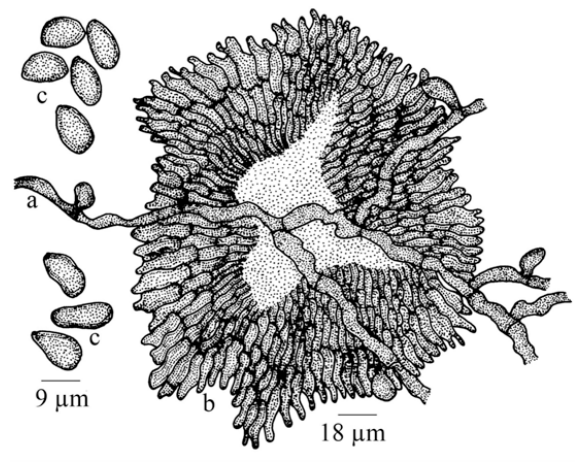
Figure 6. Asterostomella farrargunjensis sp. nov. a - Appressoriate mycelium; b - Pycnothyrium; c - Pycnothyriospores